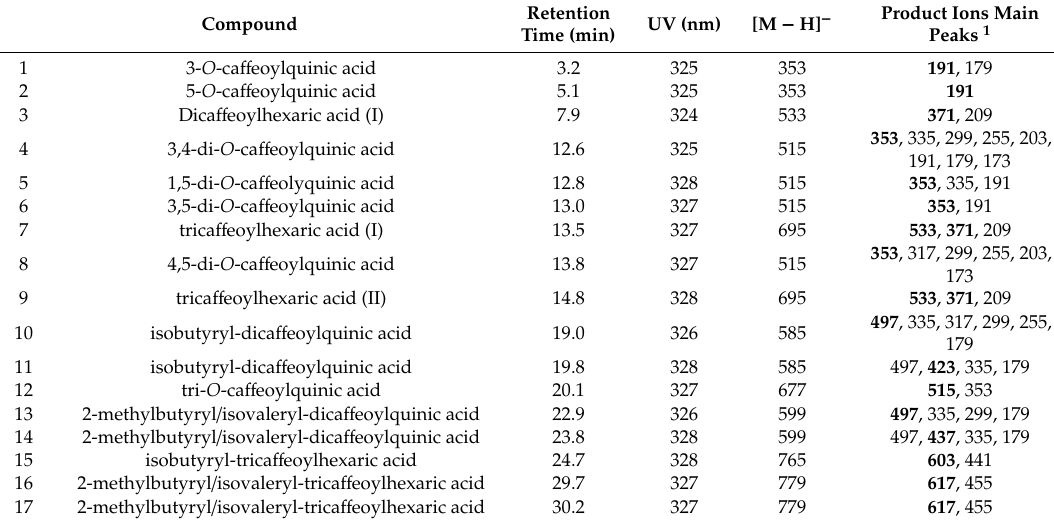
Table 1. Retention times, UV maxima, and MS n data, in the negative ion mode, for the phenolic compounds present in extracts from Carpesium divaricatum aerial parts.